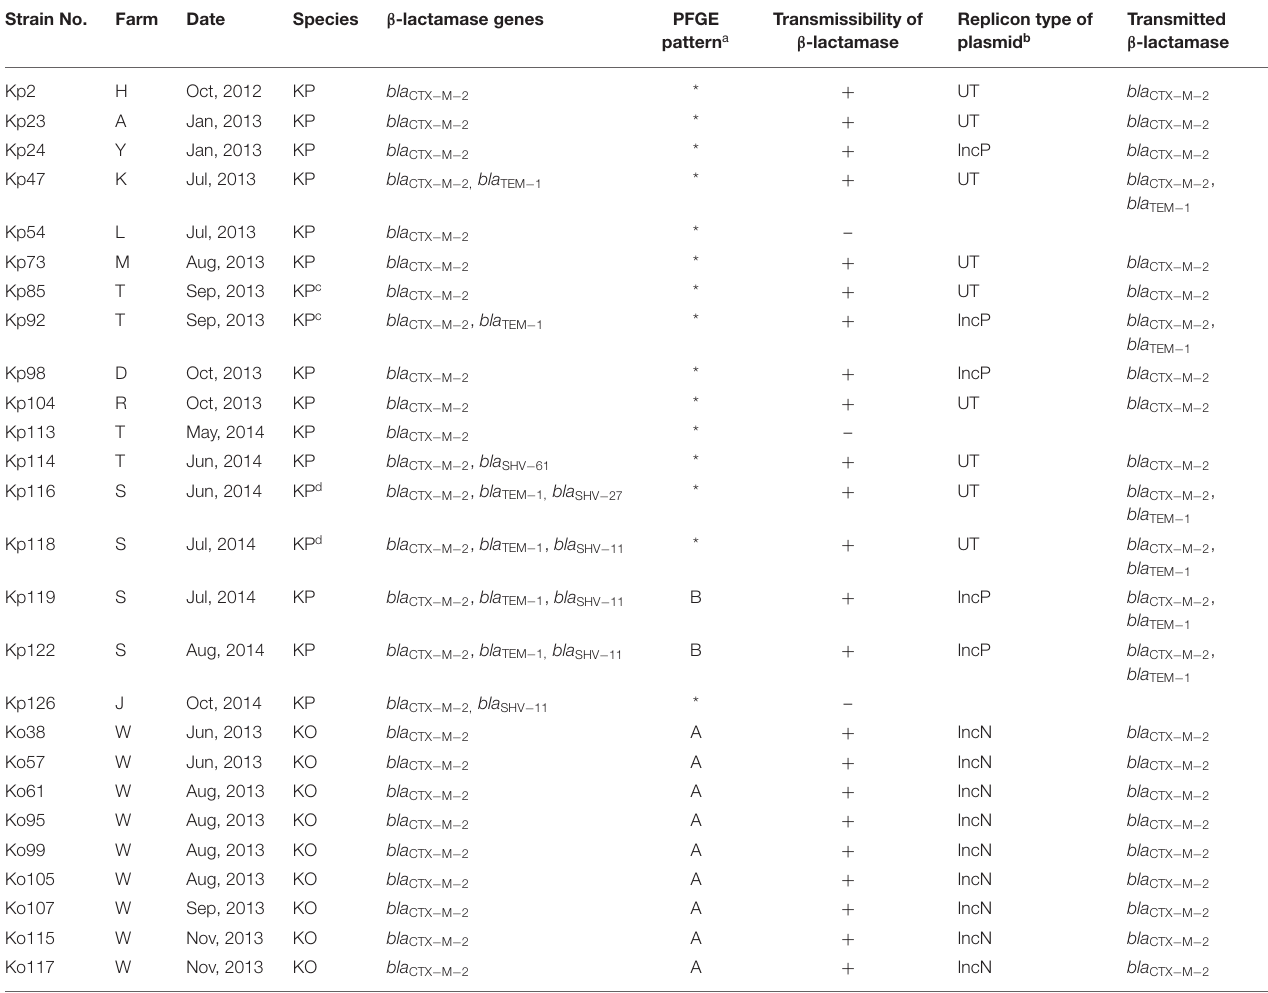
a PFGE stands for pulsed-field gel electrophoresis. A and B indicate identical patterns, and asterisks indicate different patterns. b UT, untypeable. c The KP strains were isolated from milk samples from different mammary glands of the same cow at the same time. d The KP strains were isolated from milk samples from the same mammary gland of the same cow at different times.